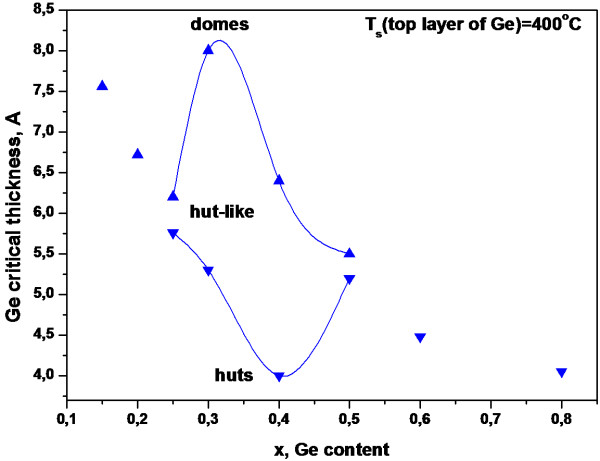
The phase diagram of the growth for Ge/GexSi1−x/Ge heterostructure.